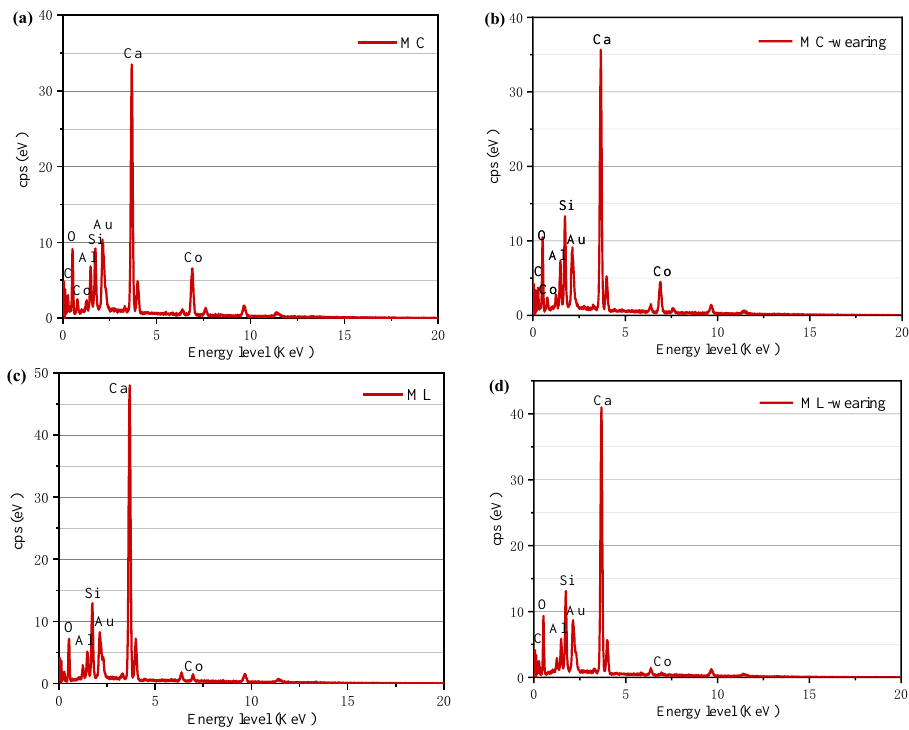
Figure 13. EDS spectra for the coated mortars before and after wearing: ( a , b ) MC; ( c , d ) ML.